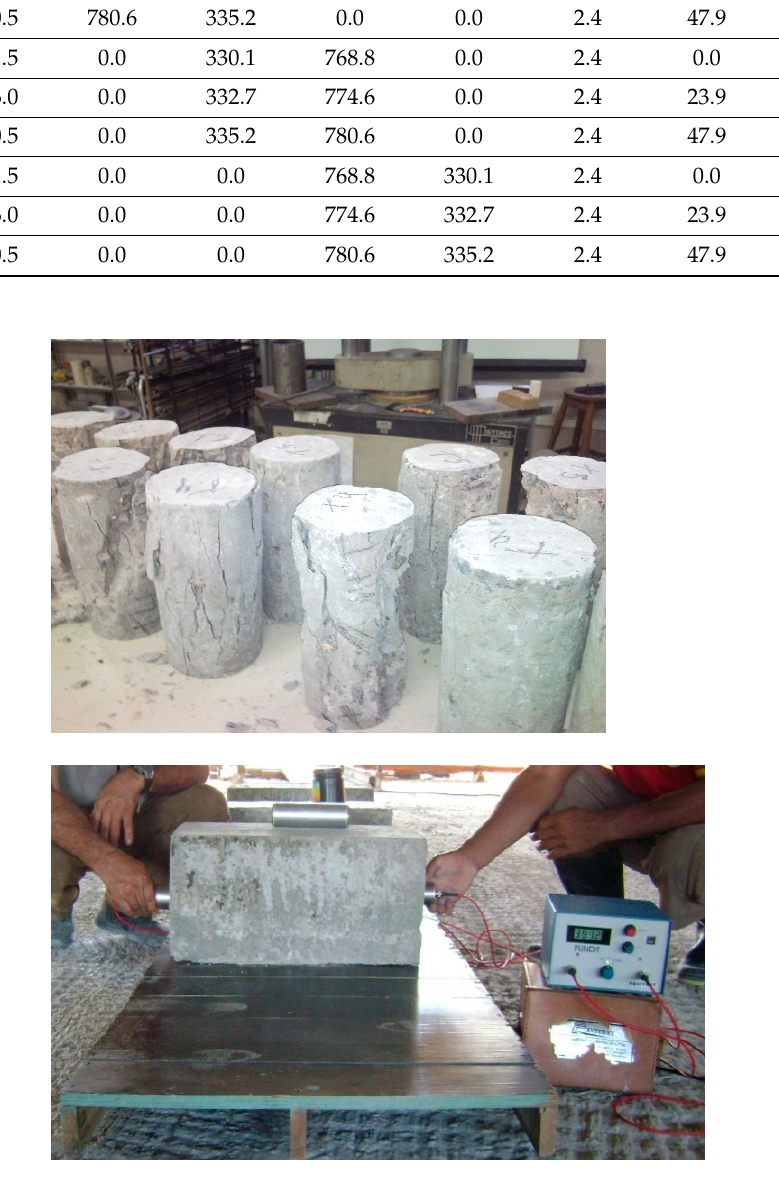
Figure 1. Specimens subjected to compressive strength tests.